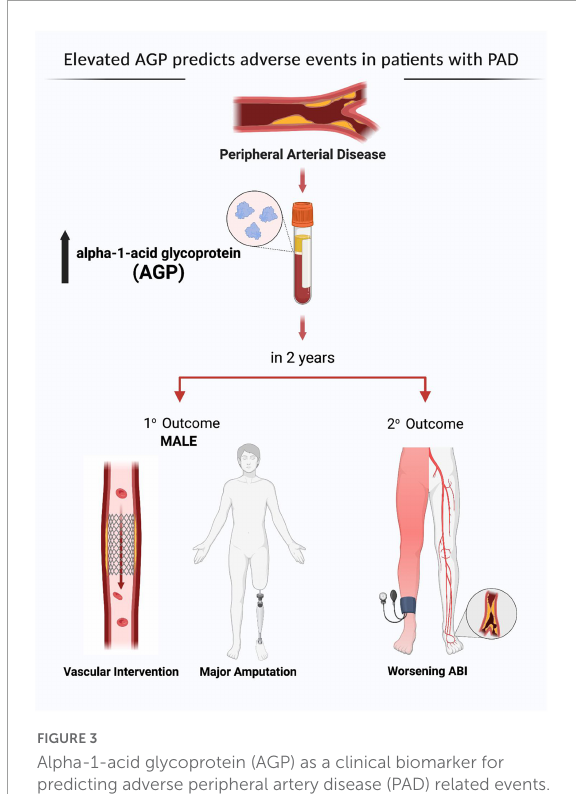
FIGURE3 Alpha-1-acid glycoprotein (AGP) as a clinical biomarker for predicting adverse peripheral artery disease (PAD) related events. MALE, major adverse limb event; ABI, ankle brachial index. Created by the authors using BioRender.com with